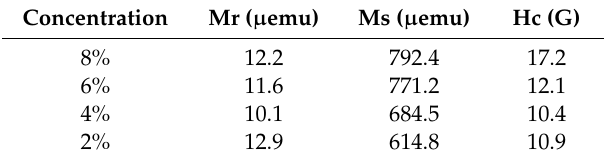
Table 1. The e ff ect of dopant concentration on magnetization of Co-doped GaN nanowires. Concentration